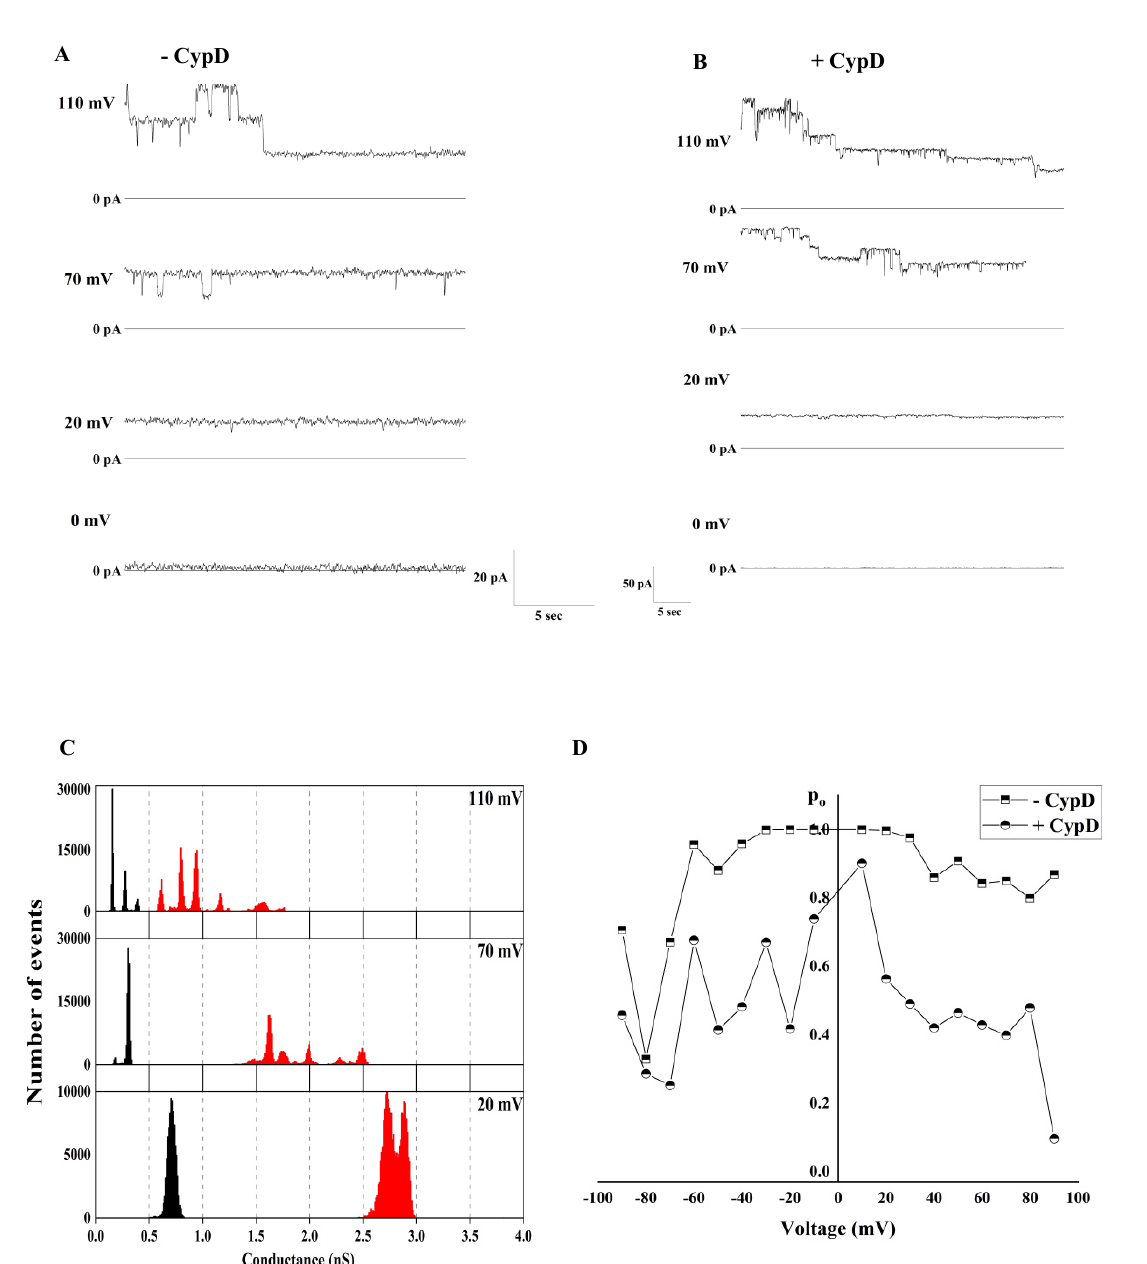
Figure 2. Voltage-dependence of c subunit channels before and after preincubation with CypD. ( A ) Representative c subunit oligomers activity at different voltages before and ( B ) after preincubation with CypD; ( C ) all points histogram corresponding to the traces shown in panel A and B; ( D ) voltage dependence of the open probability of the c subunit channel.